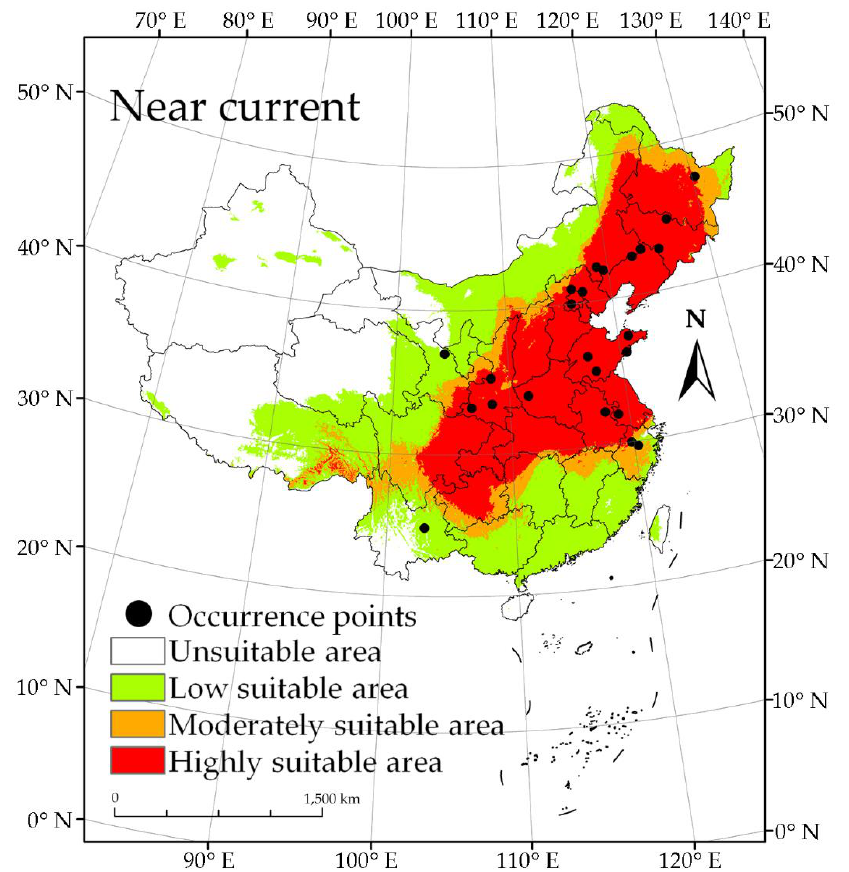
Figure 3. Current occurrence and distribution of S. nitobei in China, and the predicted area suitability under the near current climate condition. S. nitobei has the potential to occupy over 60% of the land area of China, which shows high suitability for occurrence of S. nitobei .